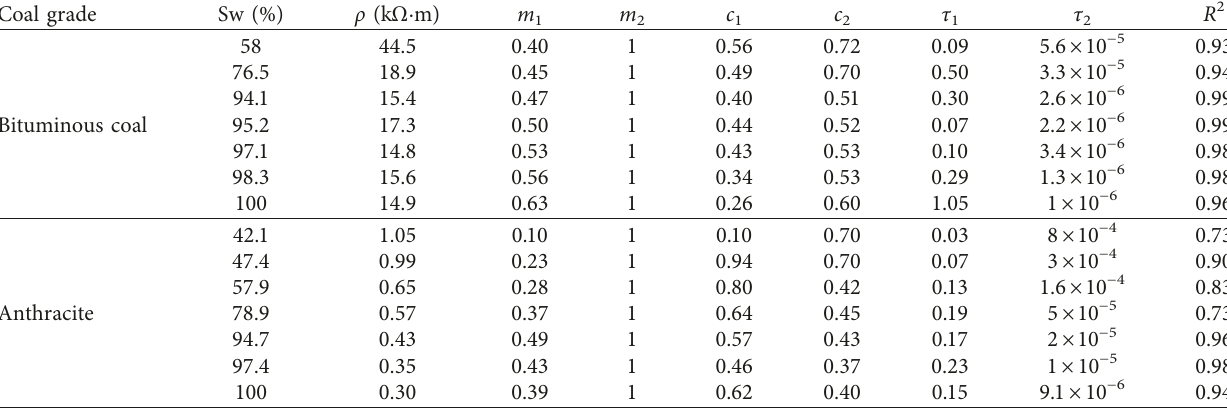
Table 2: Double Cole-Cole model parameters of two kinds of coal